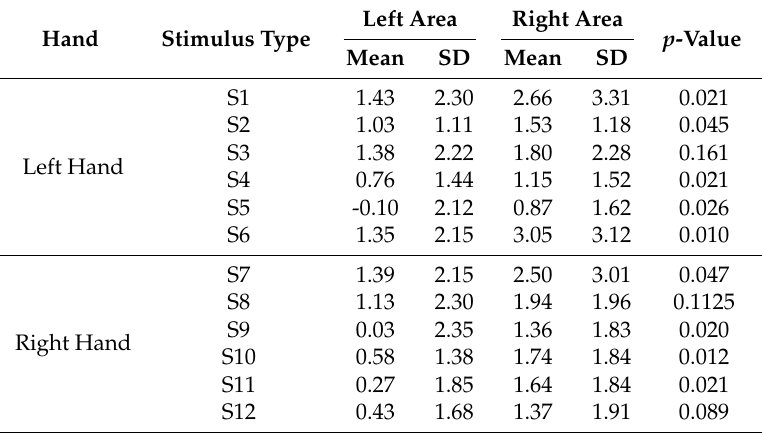
Figure 4. Grand average of microstates topographical maps of the mode A among 11 subjects for the 12 different visual stimuli. In the topographical maps of microstates, the deep red color represents a stronger brain activity and the deep blue color represents weaker brain activity. Note that microstates mode A showed a clear hemispheric lateralization at the parietal occipital area. Table 3. Grand average and SD of brain activities in microstates mode A among all subjects for visual stimuli S1 to S12. A paired t -test showed a significant difference between the brain activities in the right parietal occipital area and the left counterpart